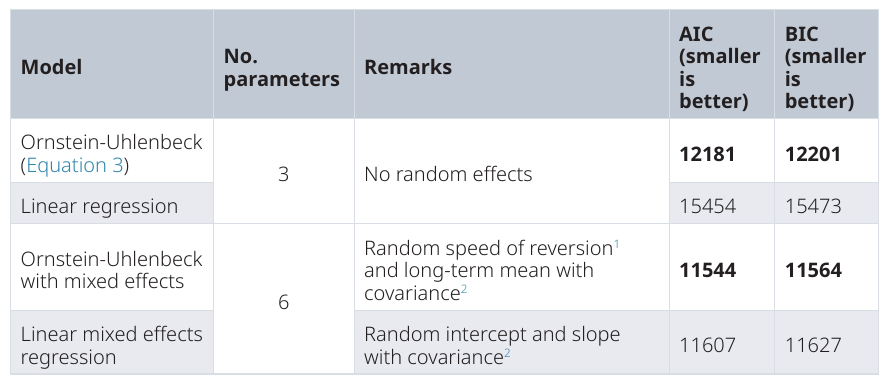
Table 1. Model goodness of fit comparisons using a selection of stochastic differential equation and linear regression